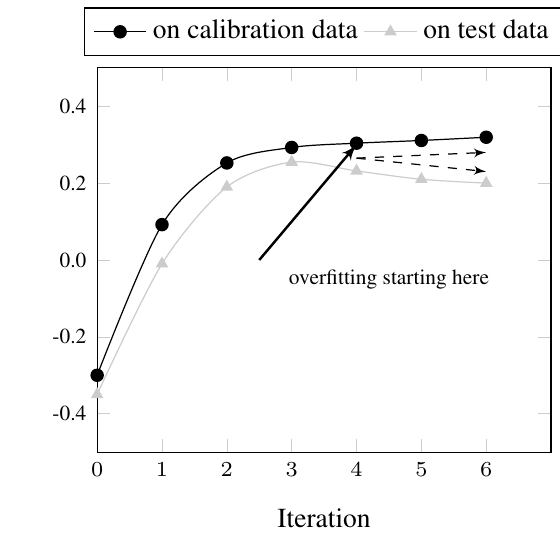
Fig. 4. Overfitting for the calibration of the model WaSiM Fig. 4: Overfitting for the calibration of the model WaSiM while calibrated with the method according to B´ardossy and Singh Fig. 4: Overfitting for the calibration of the model WaSiM (2008); flood event no. 4 was used for calibration and event no. 14 while calibrated with the method according to B´ardossy and while calibrated with the method according to B´ardossy and was used as control Singh (2008); Flood event no. 4 was used for calibration and Singh (2008); Flood event no. 4 was used for calibration and event no. 14 was used as control set event no. 14 was used as control set